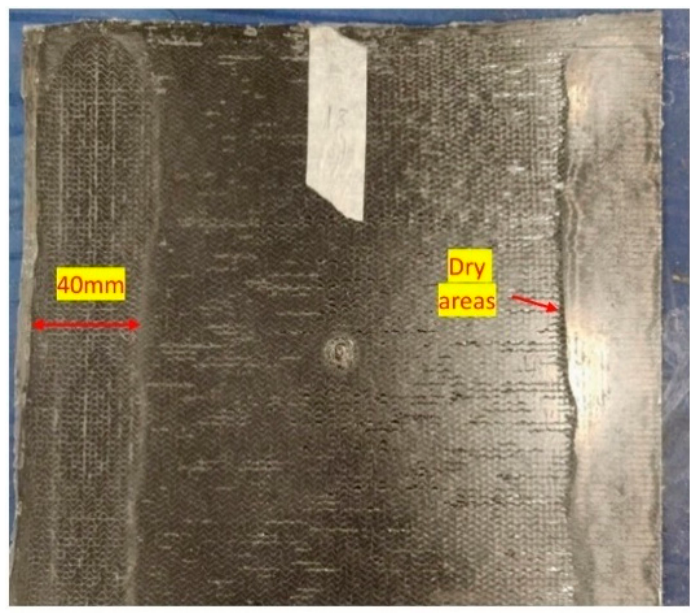
Figure 6. Defects of laminate with excessive powder. Table 2. Design of experiments using different configurations.